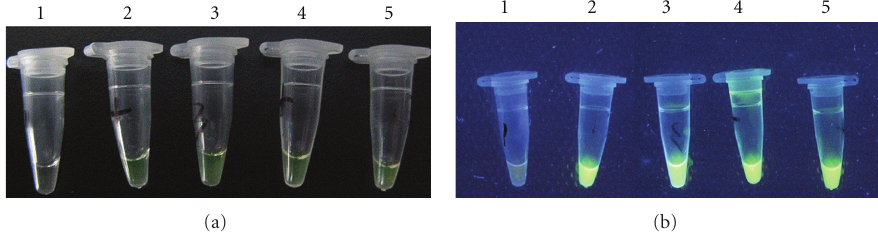
Figure 2: (a) Visualization of LAMP with SYBR Green l (reaction observed by naked eyes). 1: negative control; 2: positive control; 3– 5: samples. (b) Visualization of LAMP with SYBR Green l (reaction observed by UV lamp). 1: negative control; 2: positive control; 3–5: samples.